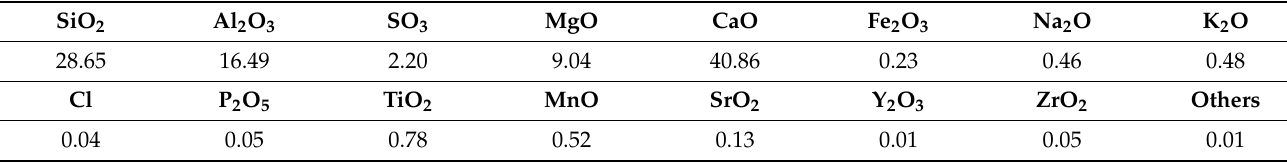
Table 1. Chemical composition of slag (mass %).